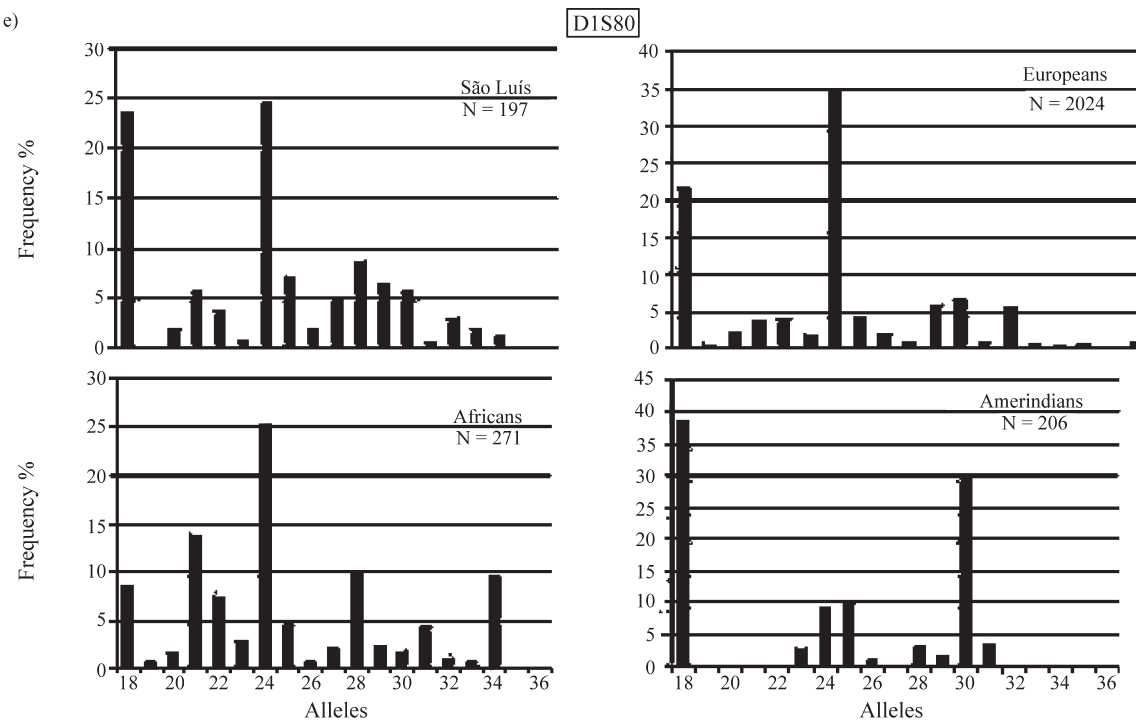
Figure 1 (cont.) - Allele frequencies in the São Luís population and in the main ethnic groups that contributed to its formation.